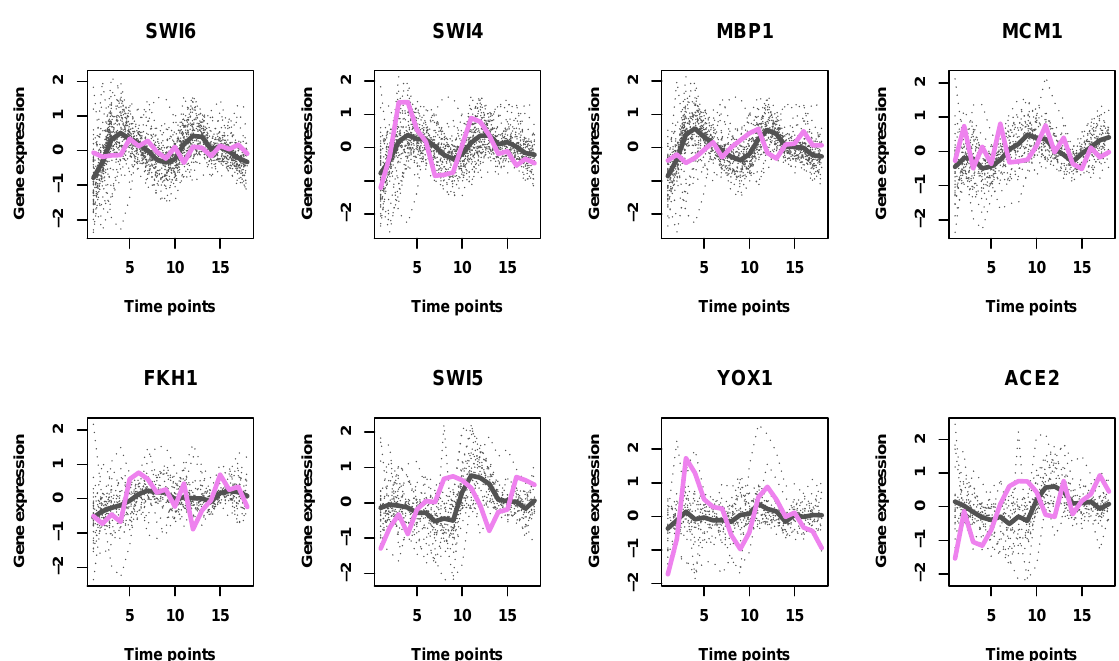
Figure 4: Plot of time series data of the eight transcription factors (pink) and the genes they are regulating